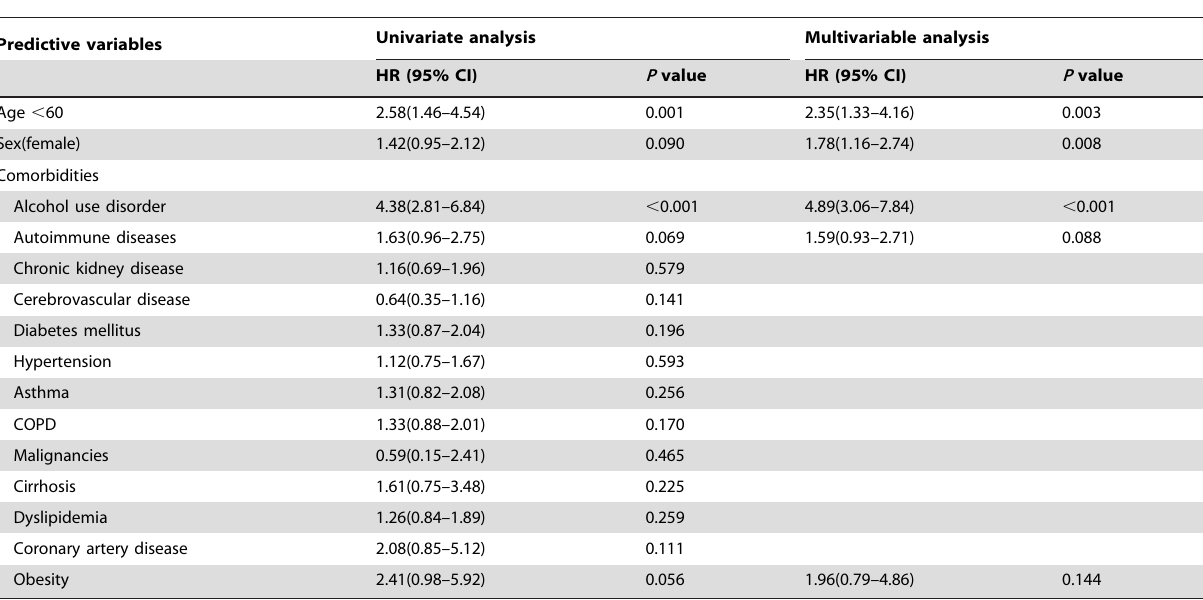
Table 3. Analyses of risk factors for bipolar disorder in patients with gastroesophageal reflux disease (GERD).